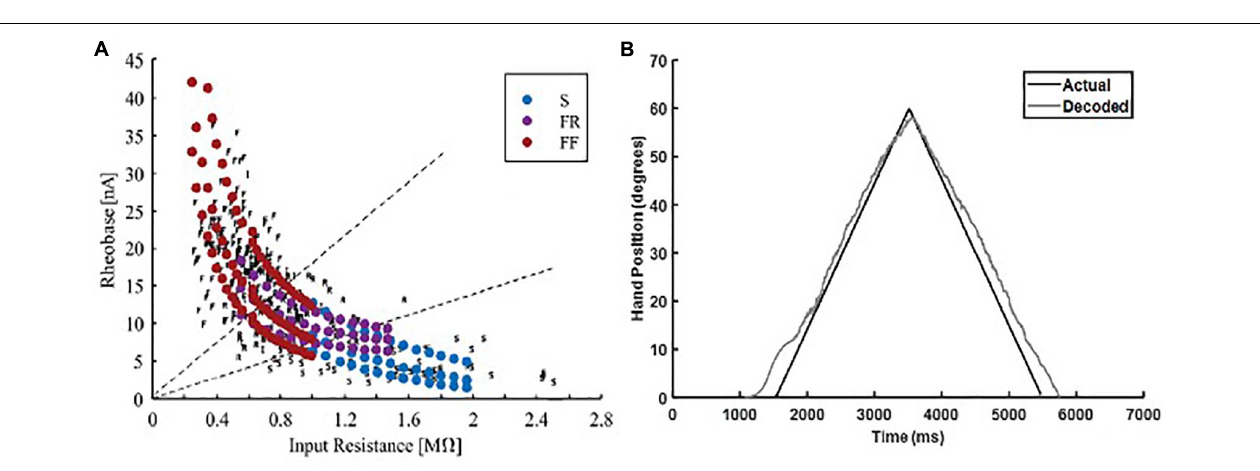
FIGURE 8 | Testing of the adaptive 3-speed decoder with the firing output of a heterogeneous MN pool. (A) Comparison of physiological activation characteristics to activation characteristics of heterogeneous MN pool (figure adapted from Allen and Elbasiouny, 2018, with permission). (B) Performance of the adaptive 3-speed decoder in driving the MuJoCo prosthetic hand in response to the output of heterogeneous MU